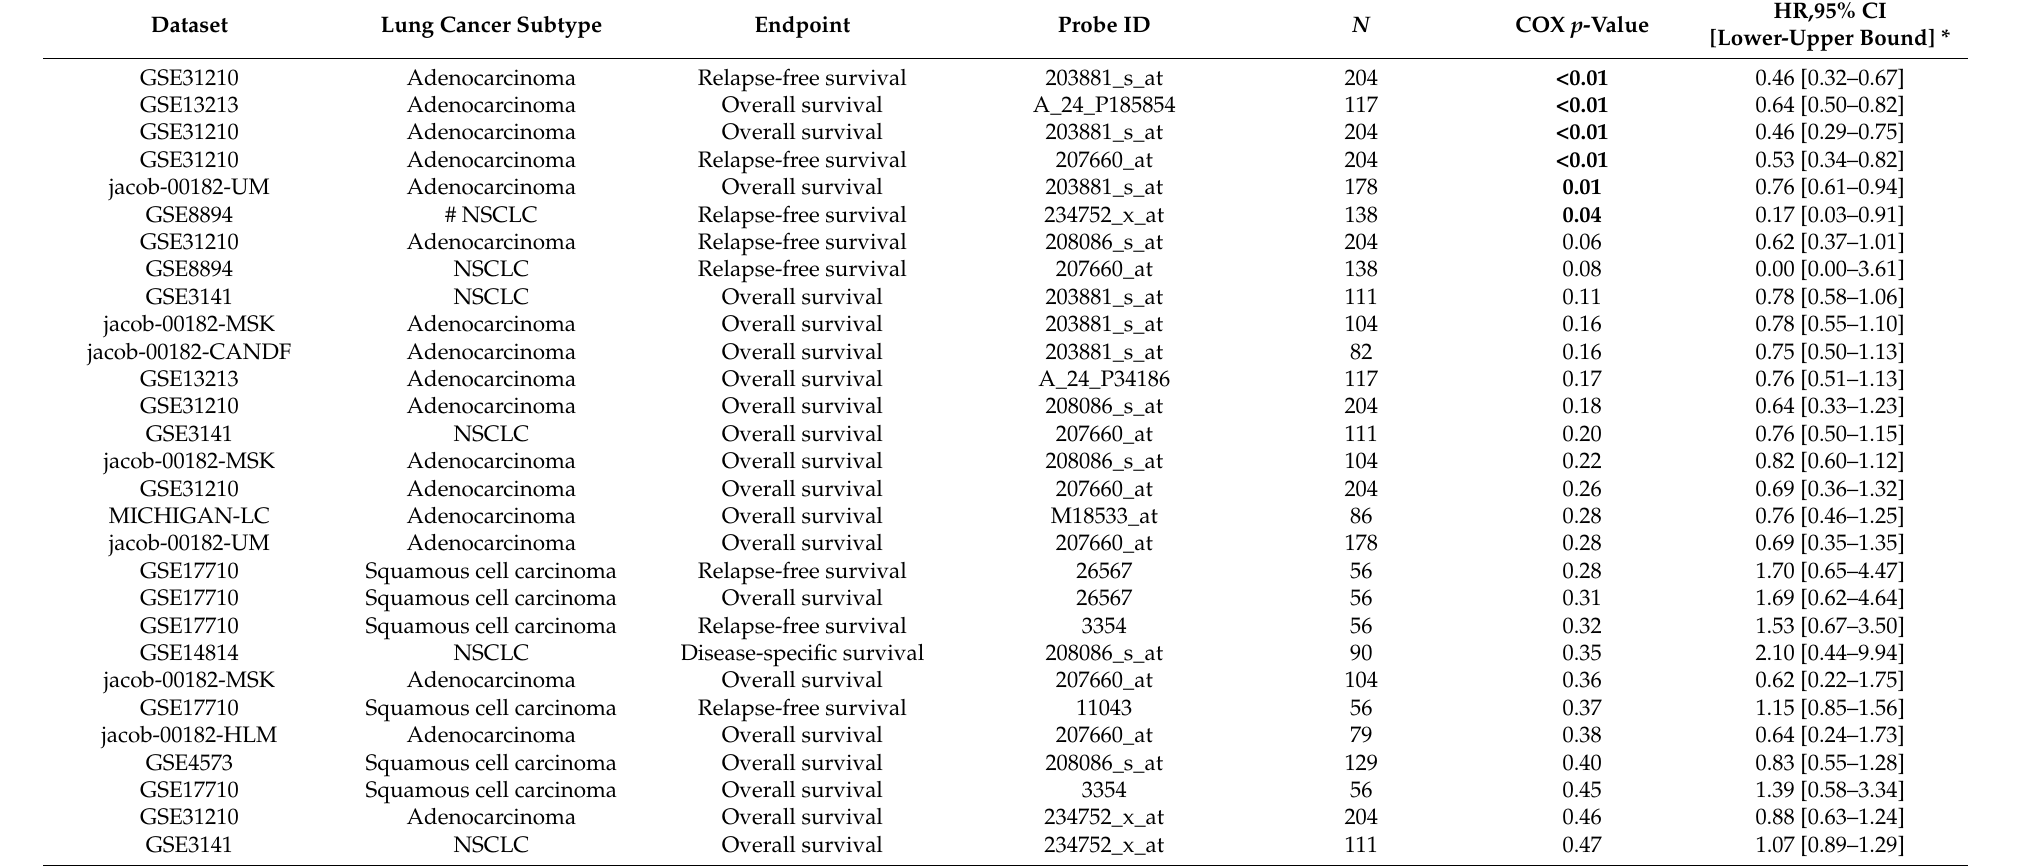
Table 7. Survival analysis of DMD in lung cancer microarray